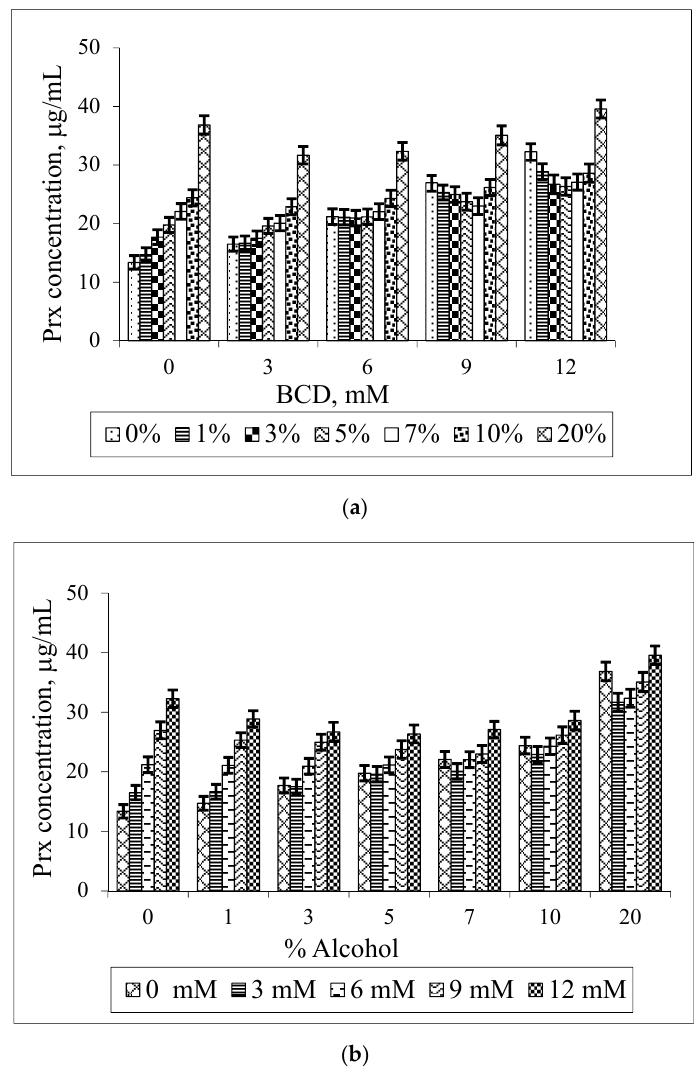
Figure 5. Effect of BCD concentrations on the solubility of Prx in Prx–BCD–ethanol ternary mixtures, varying the percentage of ethanol ( a ). Effect of ethanol on the solubility of Prx in Prx–BCD–ethanol ternary mixtures varying BCD concentrations ( b ).